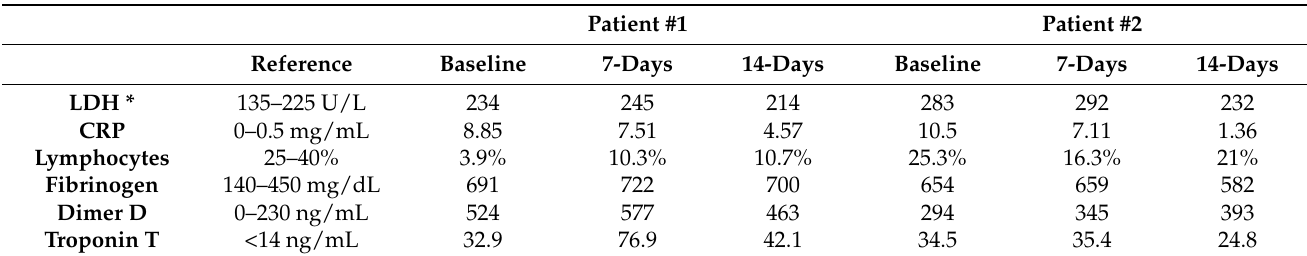
Table 1. Baseline and follow-up values of serum biochemistry in silibinin-treated cancer/COVID-19 +